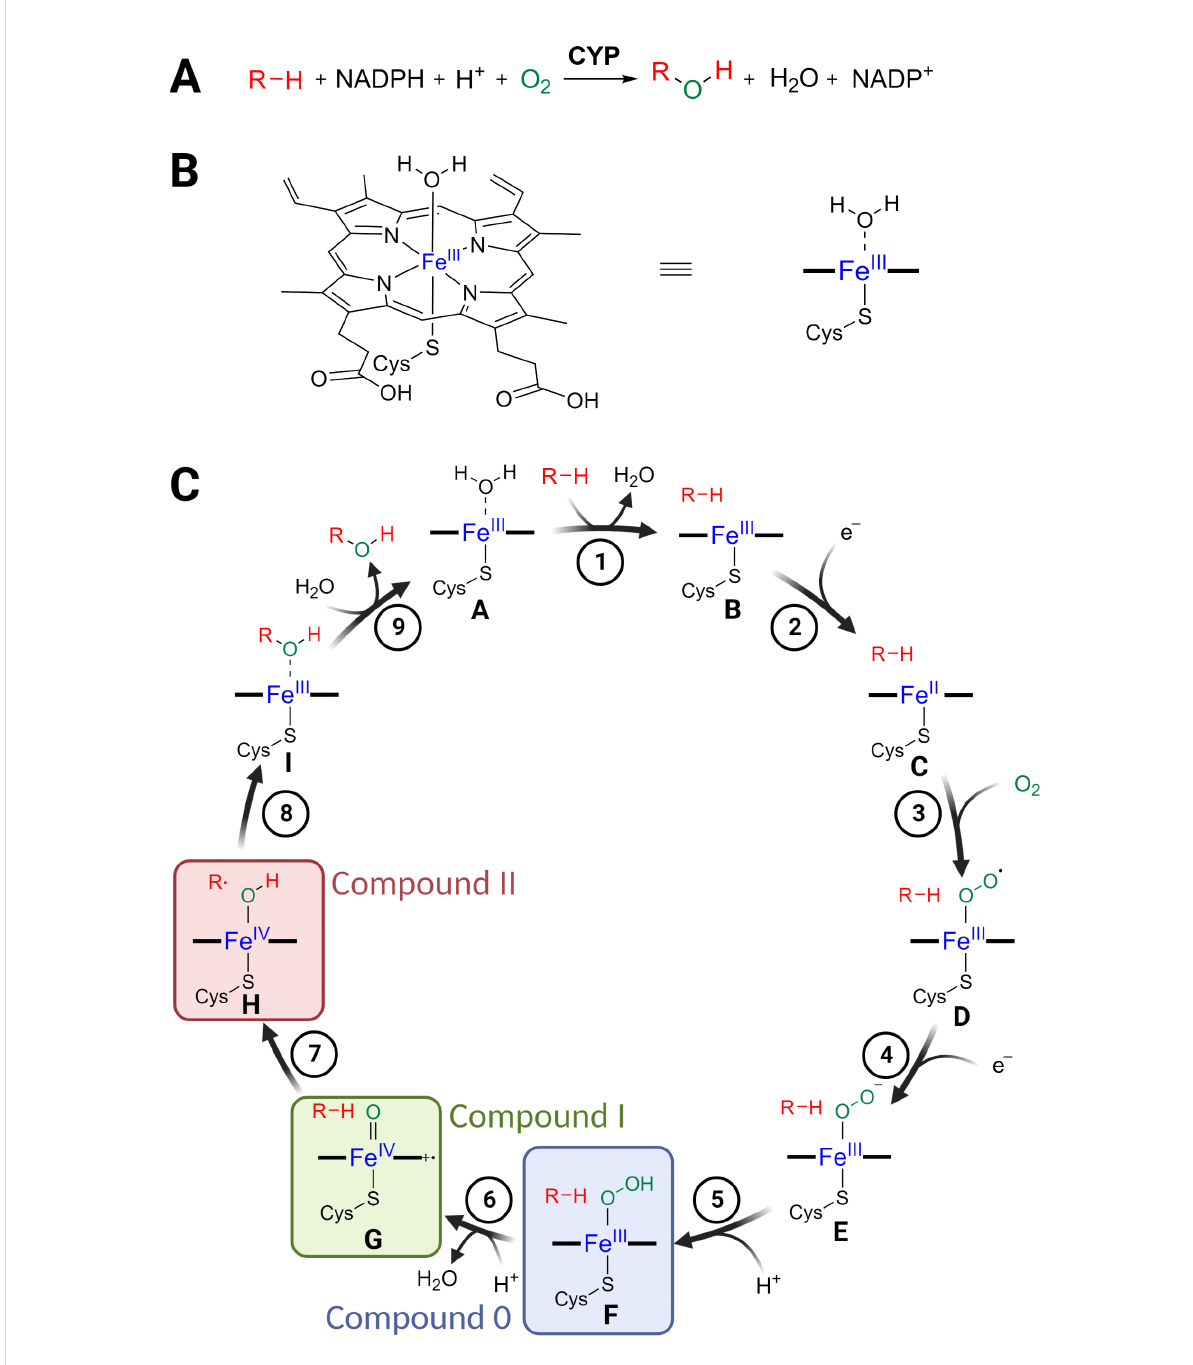
Figure 1: Enzyme function of cytochrome P450 monooxygenases (CYPs). A) Typical net reaction of CYPs, resulting in hydroxylation of a substrate. As monooxygenases, CYPs catalyse transfer of only one oxygen atom from molecular oxygen to their substrate. B) Heme prosthetic group containing the reactive Fe ion. Also shown is the abbreviated form of the cofactor used in the catalytic cycle. C) Catalytic cycle of CYPs. The key intermediates F , G , and H , called compound 0, compound I, and compound II, respectively, are highlighted. For details see main text. Figure 1 was created with BioRender.com. This content is not subject to CC BY 4.0.